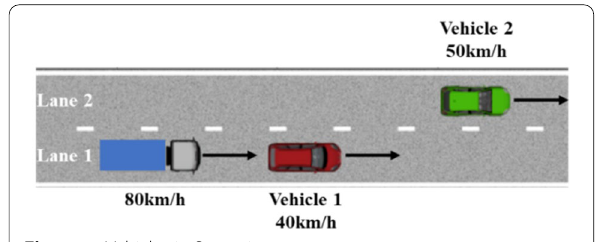
Figure 5 Vehicles in Scenario 1